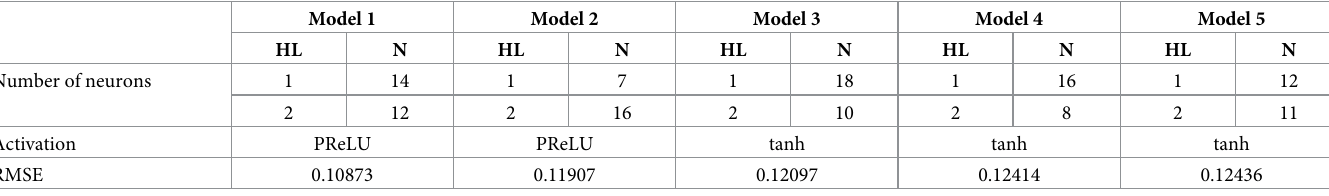
Table 9. Hyperparameter search results summary (Run 2). Top 5 Models out of 250 candidate models from Run 2.